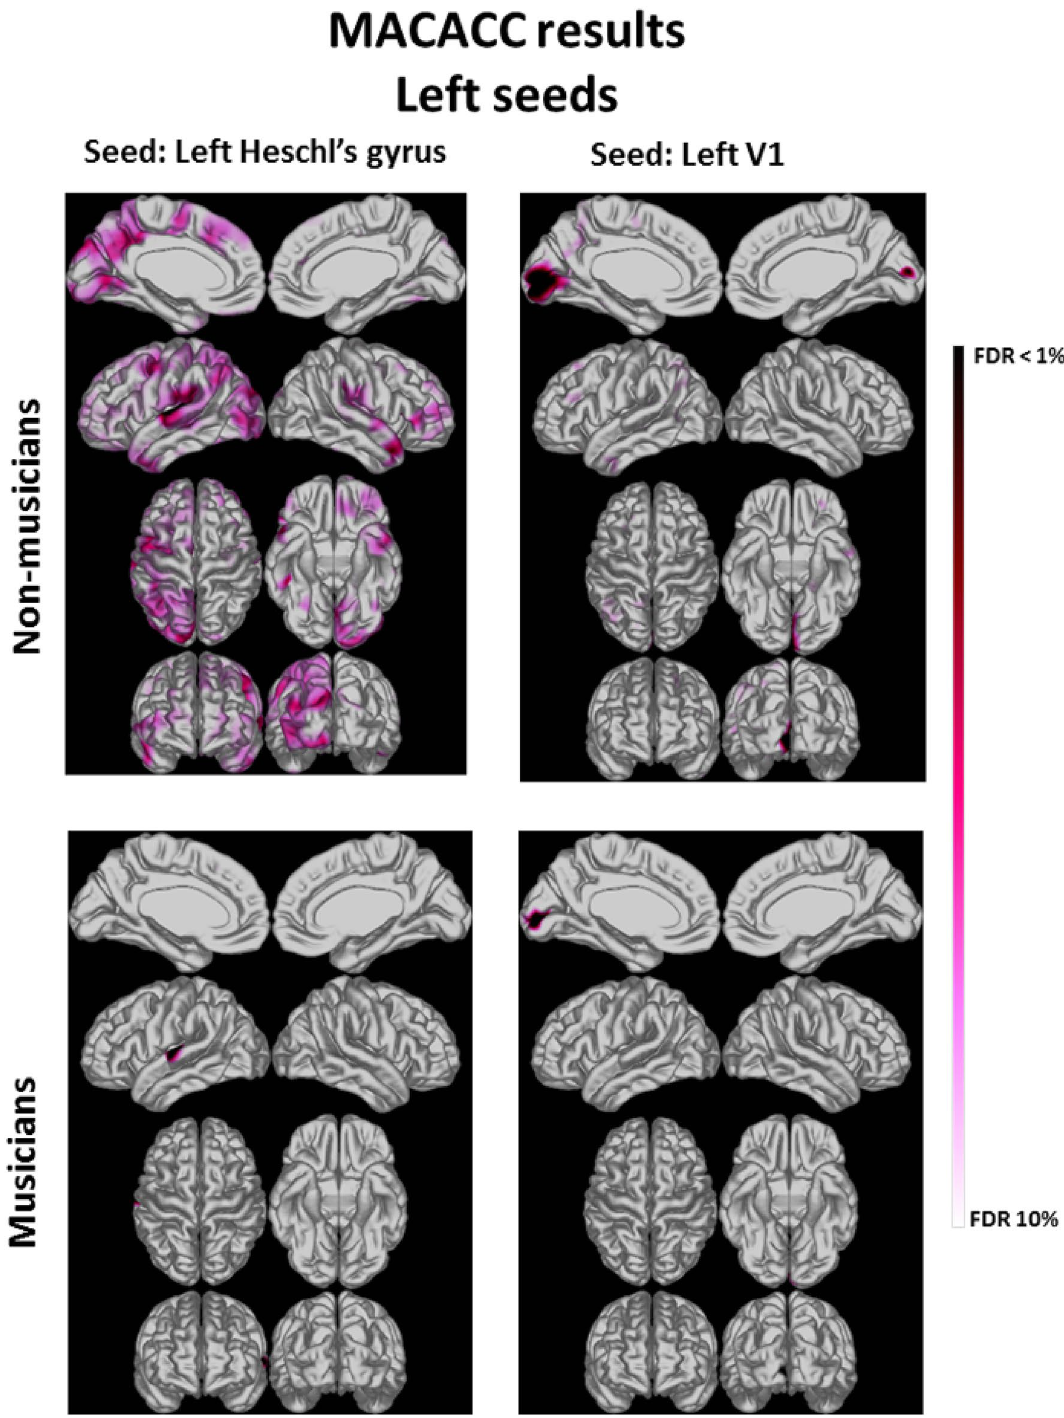
Figure 3. Significant correlations between the cortical thickness (CT) of vertices of the whole brain and vertices of seeds in left Heschl’s Gyrus (left column) and left V1 (right column). FDR = False discovery